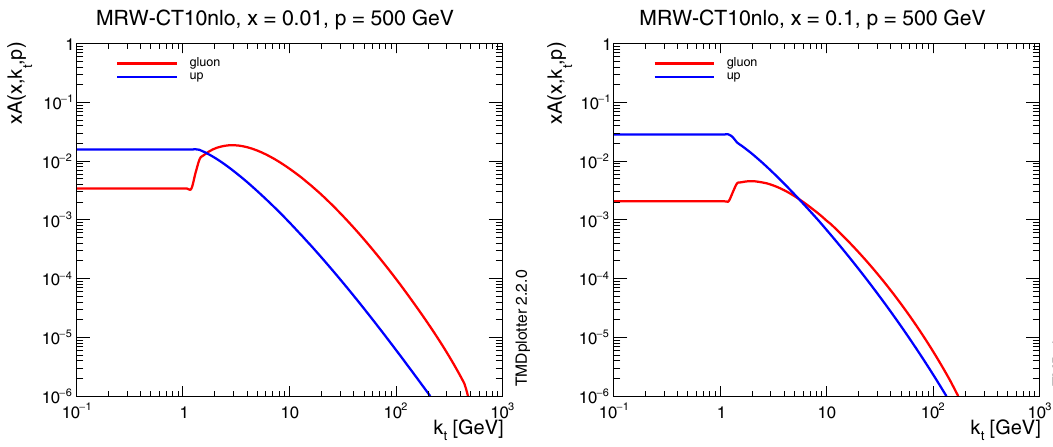
Fig. 2 Transverse momentum distribution of the TMD at a scale μ = 500 GeV for gluons and u-quarks at x = 0 . 01 (left) and x = 0 . 1